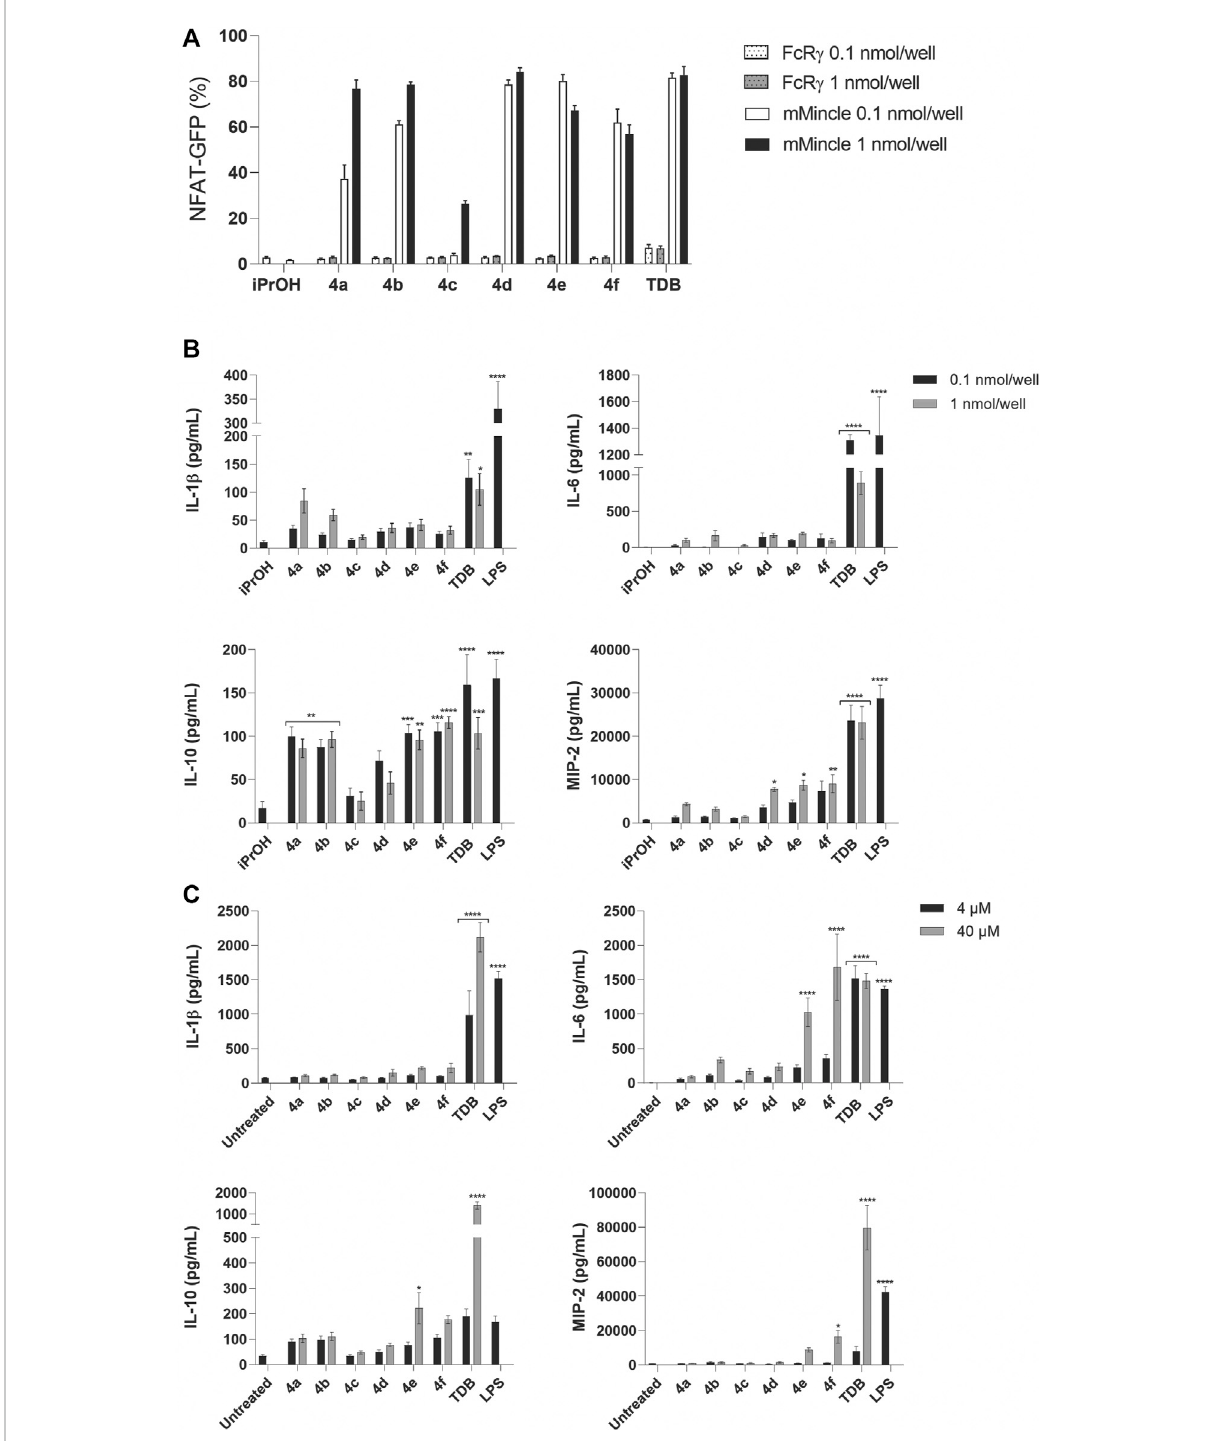
FIGURE 4 PEGylated TGLs ( 4a-f ) led to strong mMincle signaling but modest cytokine production. (A) Reporter cells expressing mMincle + FcR γ or FcR γ onlywerestimulated withligandscoated onplates(0.1and1 nmol/well).NFAT-GFPexpressionbytheharvestedcellsafter 18 hwasmeasuredusing fl owcytometry.Datarepresentsthemeanoftwoindependentexperimentsperformedinduplicate(mean±SEM). (B) WTC57GM-CSFtreatedBMCs were stimulated with TDB or 4a-f (0.1 or 1 nmol/well) coated on plates, or LPS (100 ng/ml), and IL-1 β , IL-6, IL-10 and MIP-2 were measured by ELISAfromthesupernatants collected after24 h.Datarepresents themeanofthreeindependent experiments performedintriplicate (mean±SEM).